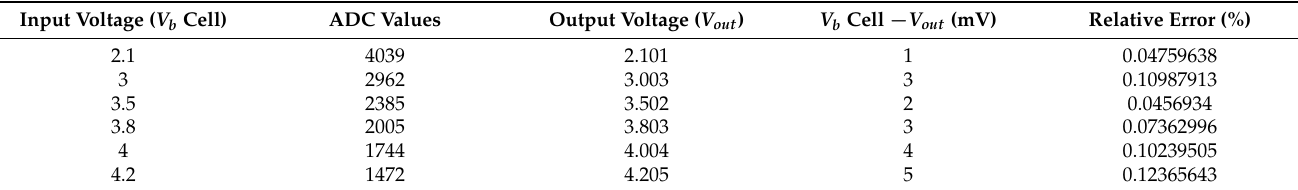
Table 3. Experimental